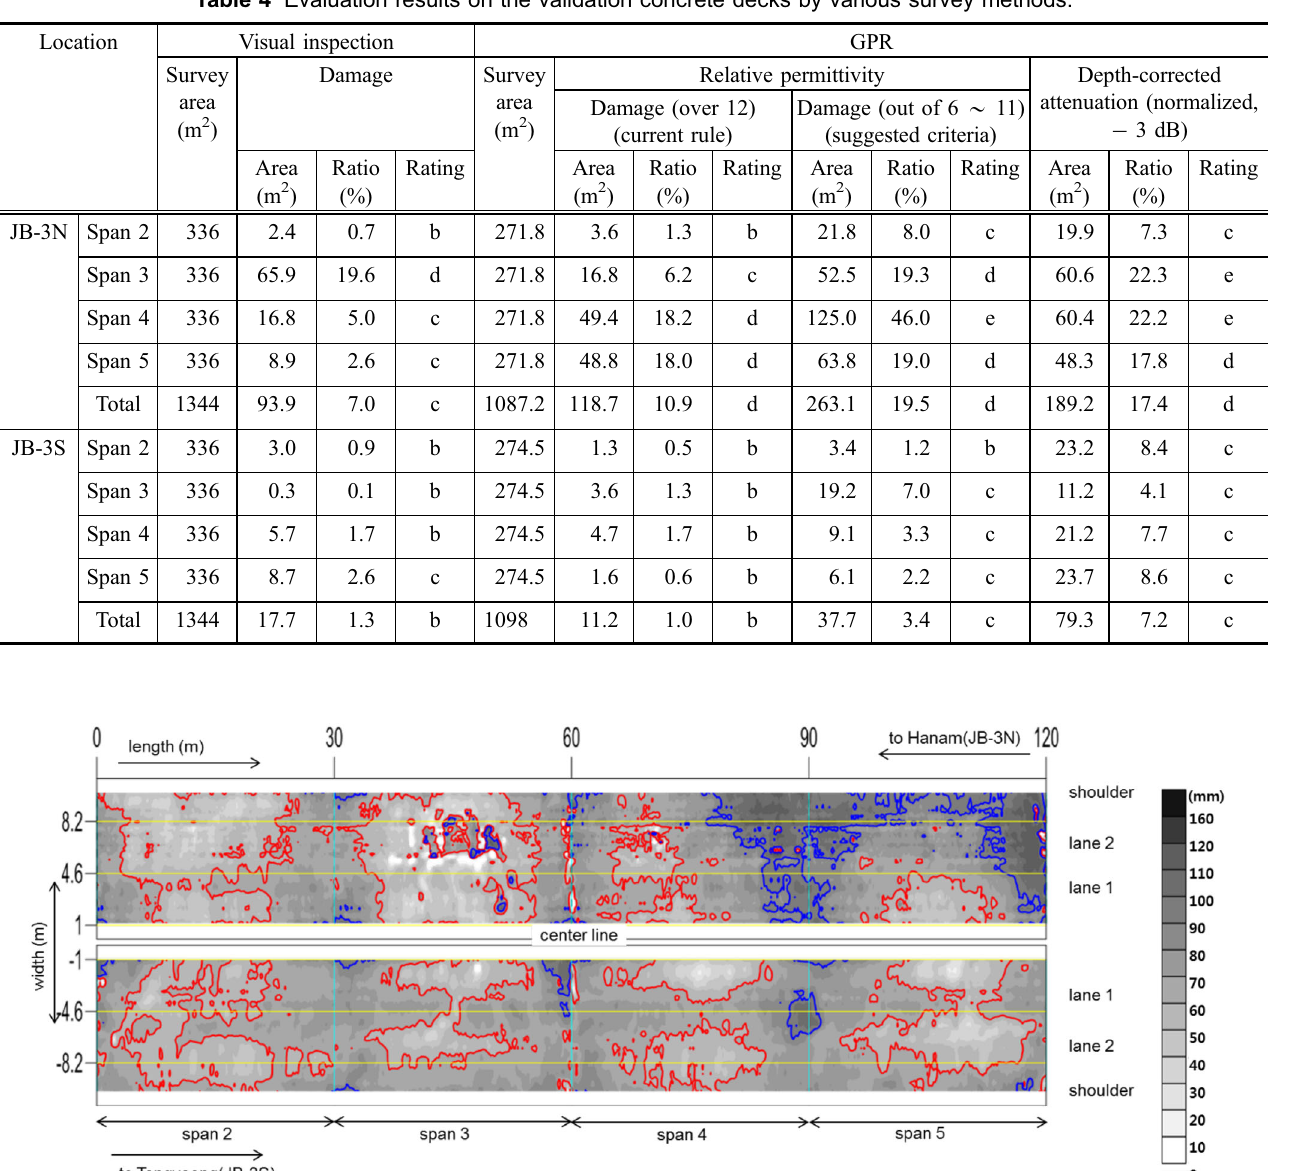
Table 4 Evaluation results on the validation concrete decks by various survey methods.